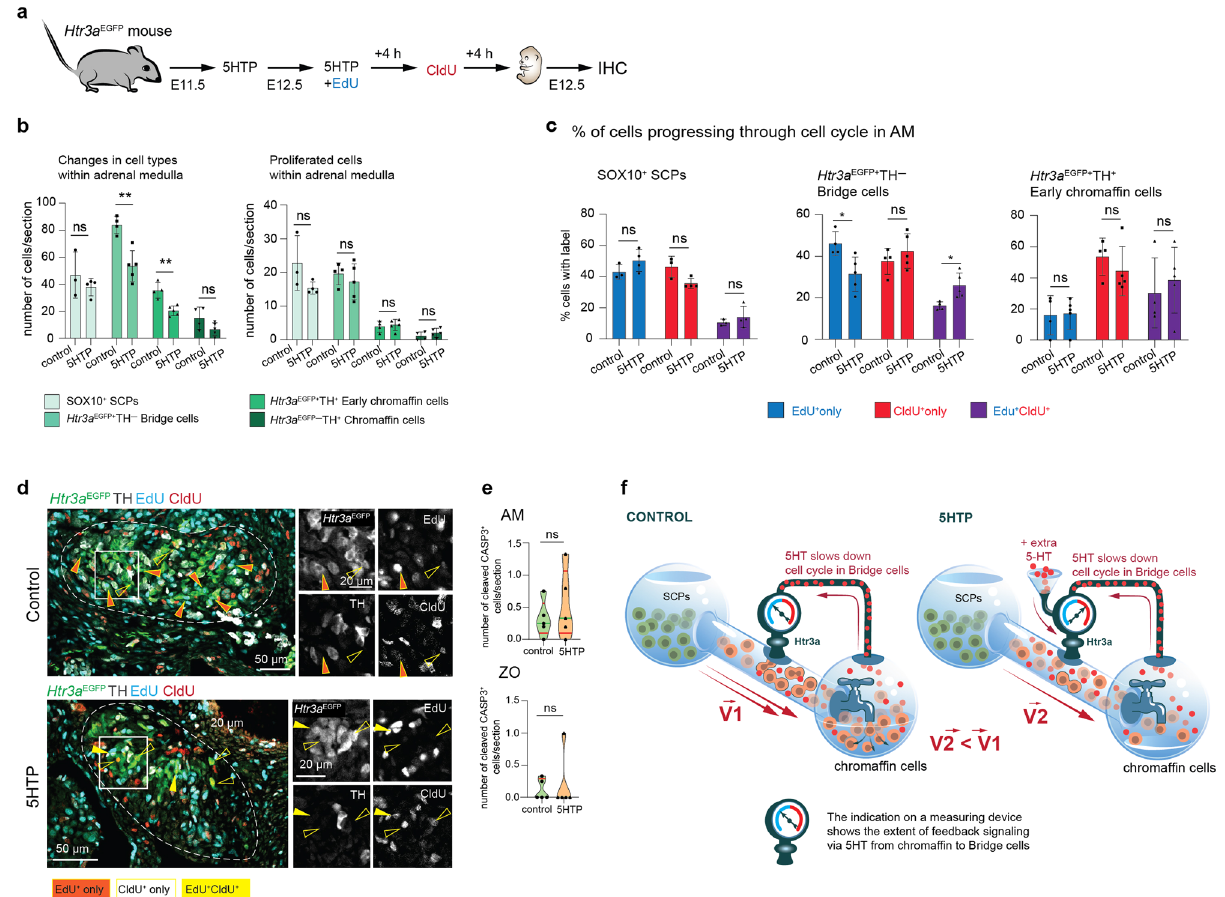
Fig. 4 Prenatal 5HT in fl uences cell cycle length of the “ bridge ” progenitors in embryonic adrenal glands. a Pregnant Htr3a EGFP + / − females were administered 5HTP at E11.5; at E12.5, females received 5HTP together with 5-Ethynyl-2 ′ -deoxyuridine (EdU); in 4 h females received 5-Chloro-2 ′ - deoxyuridine (CldU); embryos were harvested in 4 h after CldU injection at E12.5. This allows identifying the proportions of cells, which incorporated EdU + only, CldU + only, or both thymidine analogues (EdU + CldU + ). b Numbers of all cells (left) and numbers of proliferated cells (right) in populations of SCPs,